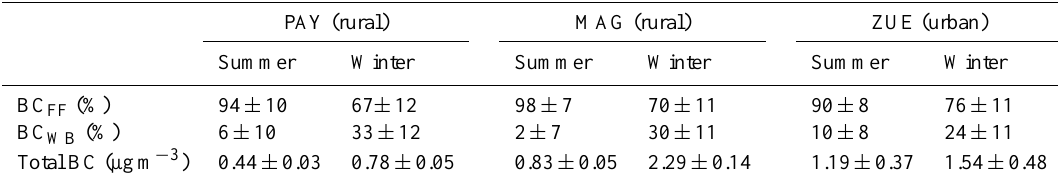
Table 3. Contribution of BC FF and BC WB to total BC at the PAY, MAG and ZUE sites. Note that the given absolute BC values are consistent with EC as derived with the thermal-optical transmission method (TOT) using the EUSAAR 2 temperature